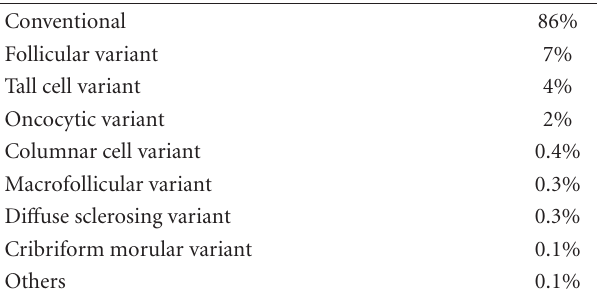
Table 1: Prevalence of conventional and various histologic variants in 1521 papillary